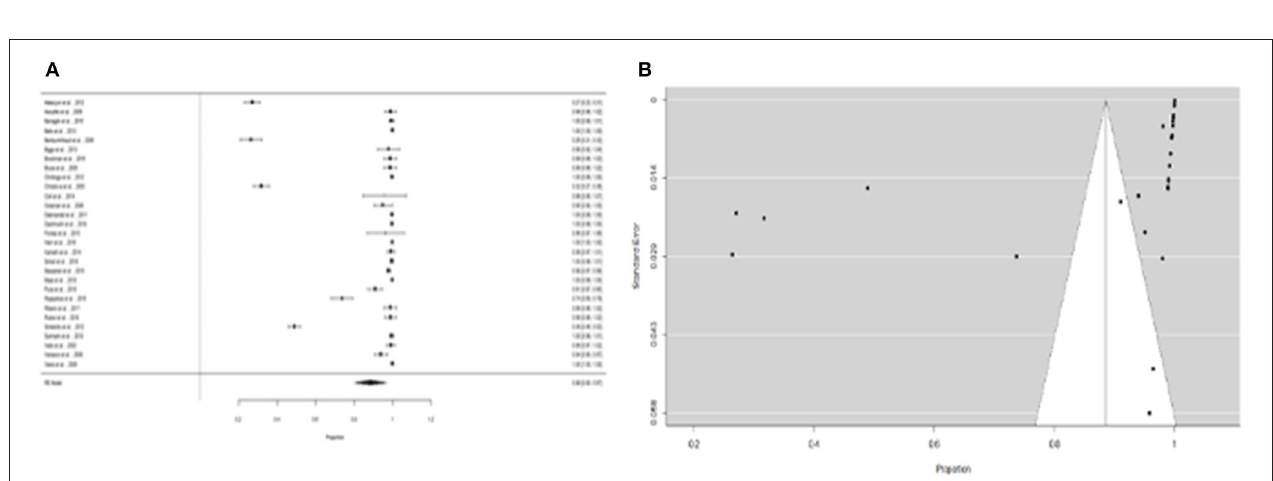
FIGURE 4 | (A) Forest plot of the proportion of “fever and two more symptoms” for leptospirosis patients. (B) Funnel plot of the proportion of ”fever and two more symptoms" for leptospirosis